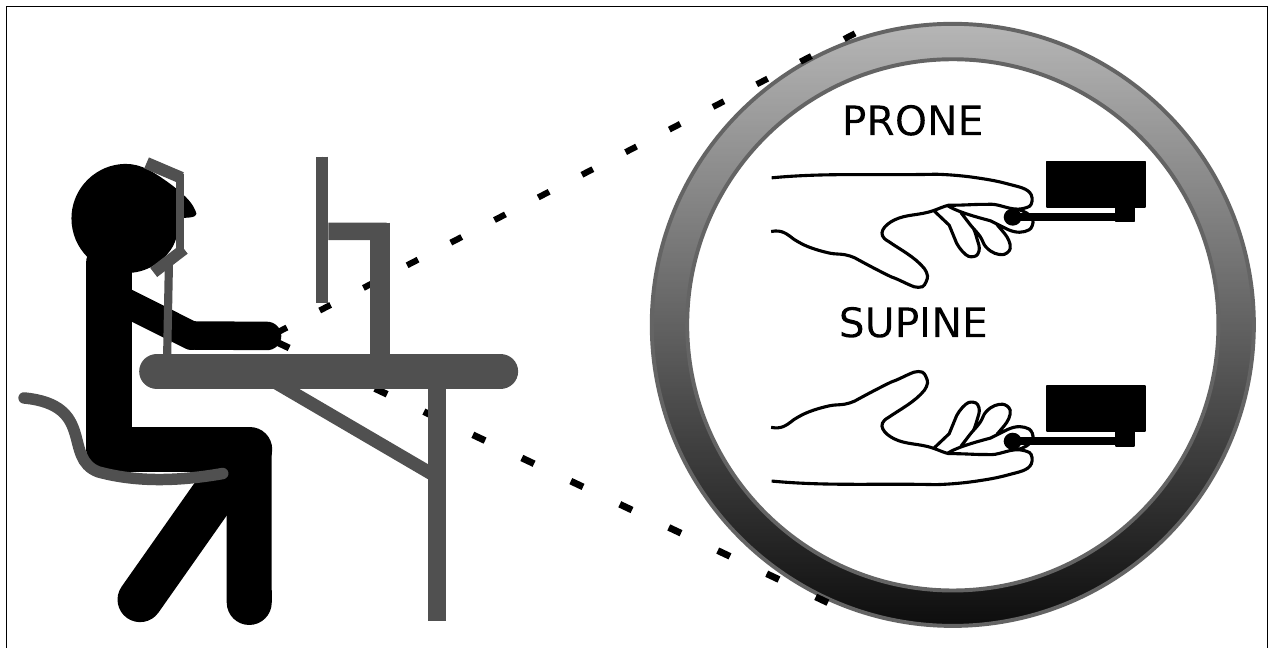
FIGURE 2 | Experimental setup and the two hand postures assumed by the